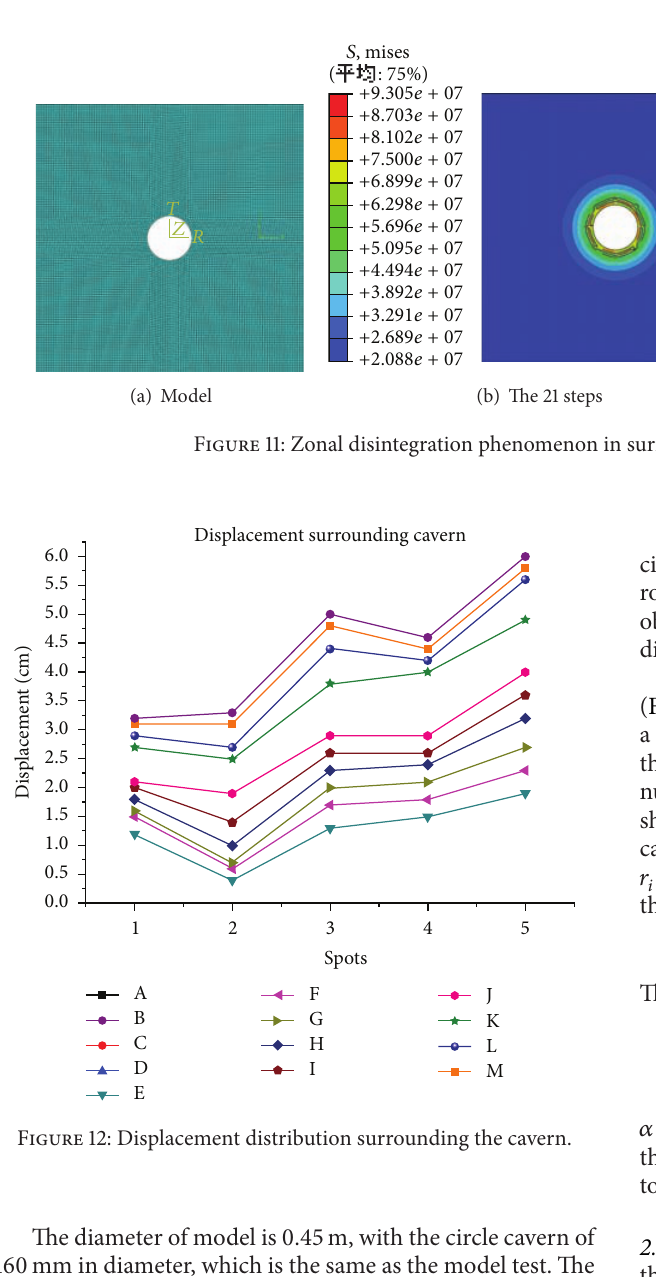
The diameter of model is 0.45 m, with the circle cavern of 160 mm in diameter, which is the same as the model test. The model is divided into 30000 elements (four-node). In order to simplify the issue, the hydraulic pressure is applied on the model, which is 0.5